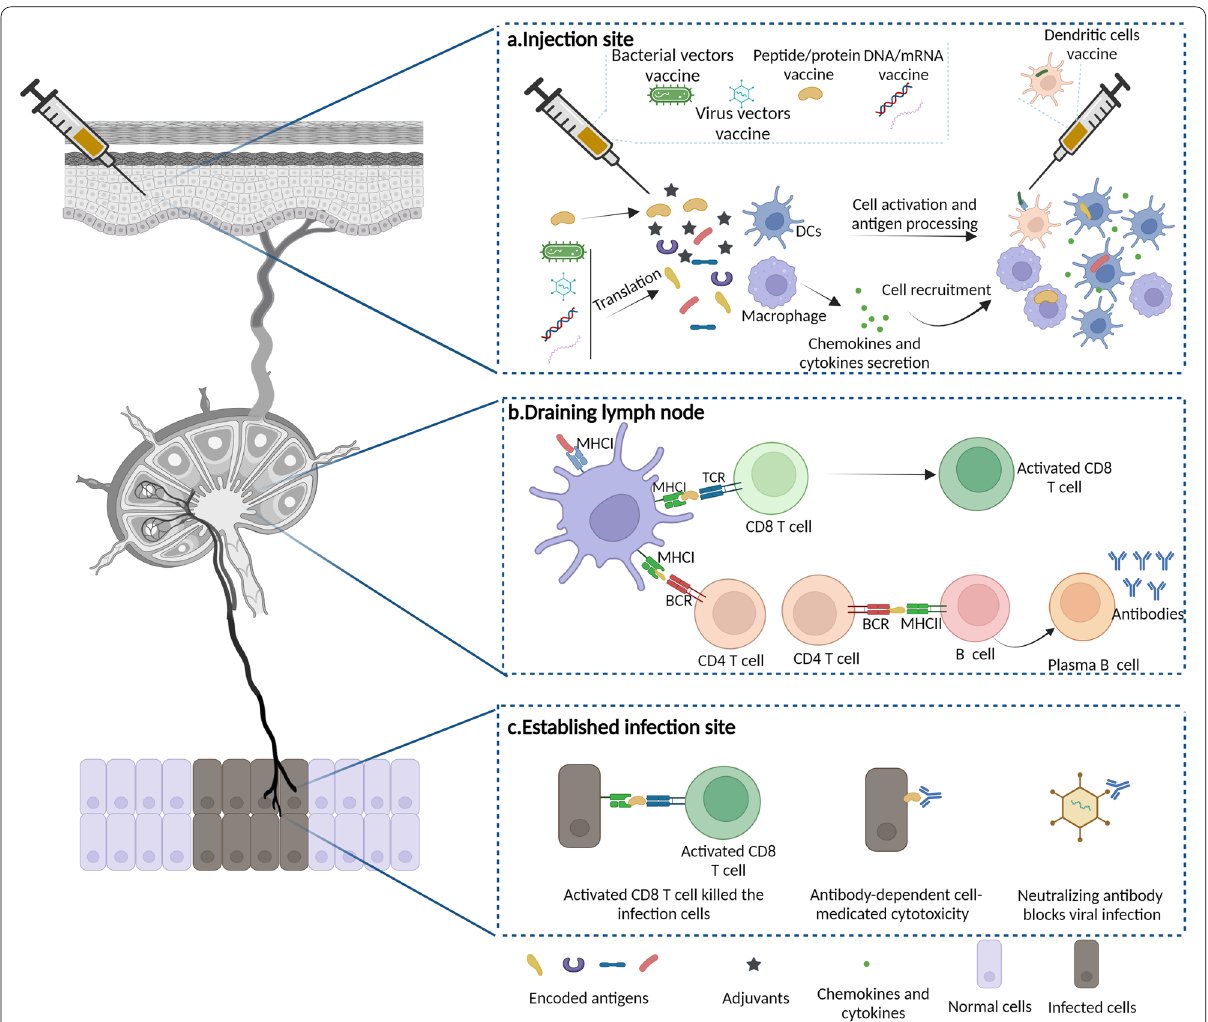
Fig. 3 Therapeutic vaccine immunity. a Therapeutic vaccine, such as including bacterial vectors vaccine, viral vectors vaccine, peptide/protein vaccine, DNA and mRNA vaccine were injected locally. Adjuvants in the vaccine in local sites activate the resident innate immune cells and result in the release of chemokines (CCL2 ， CXCL1 et al) and cytokines, which subsequently recruits macrophages and DCs to the site of injection. The encoded antigen of the vaccine in the injection site is endocytosed by DCs; b Activated DCs in the vaccination sites travels to the draining lymph nodes. Upregulation of MHCII and co-stimulatory molecules such as CD40, CD80, and CD86 on the surface of DCs and cytokines are essential for DCs activation. Migratory and activated DCs present antigen in form of peptide-MHC complexes directly to T cells in the lymph nodes. Meanwhile receiving the co-stimulatory and cytokine signals, CD8 + T cells are activated. Antigen-activated B undergo maturation and expressed antigen-specific antibodies; c Antigen-specific CD8 + T cells and antigen-specific antibodies infiltrated into infection and lesions to conduct the